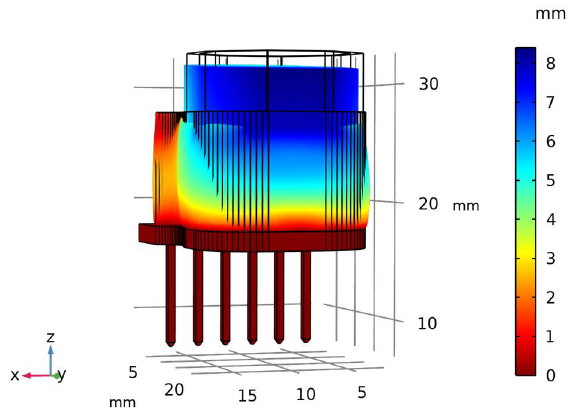
Figure 7. Displacement profile of the sensor at maximum input force of 20 N.